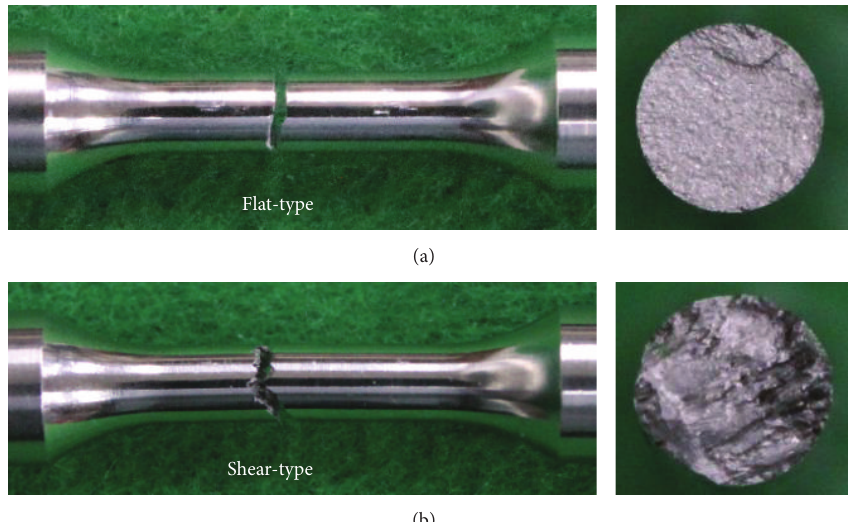
Figure 9: The fracture surface morphologies for (a) the BM and (b) WJ tested under total strain range, 0.6% condition.